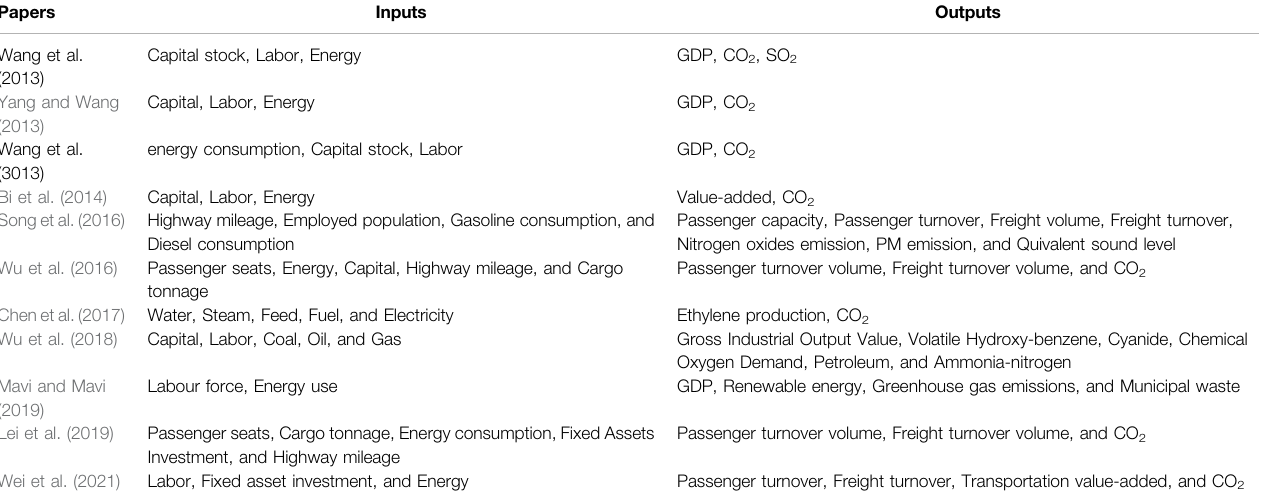
TABLE 1 | The inputs and outputs of energy and environmental ef fi ciency.